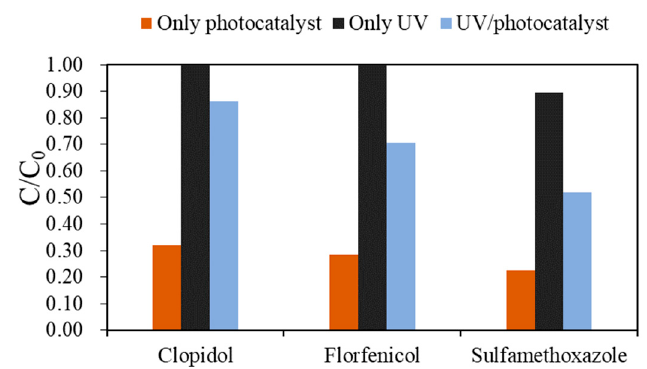
Figure 17. Exceptional behavior of the specific antibiotic towards (i) only UV (ii) only TiO 2 photocatalyst and UV/TiO 2 photocatalyst.